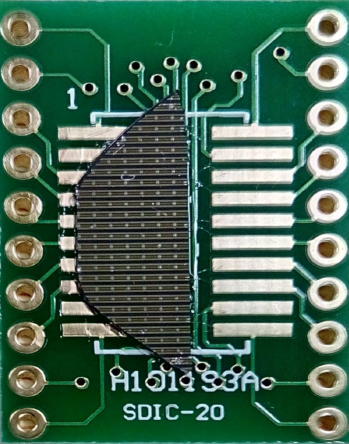
Figure 3. The chip with a set of membranes on the board.